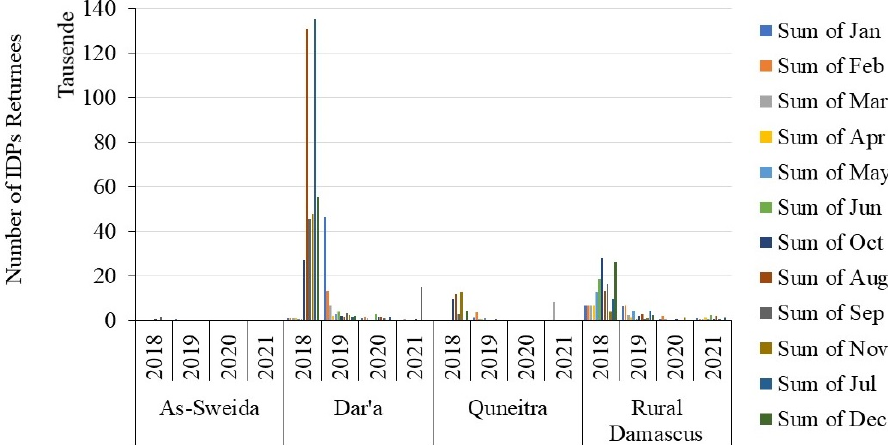
Figure 2. Summary of the total IDP spontaneous returnees in Dara’a, Quneitra, As-Sweida, and Rural Damascus governorates which mainly consist the Syrian part of YRB.